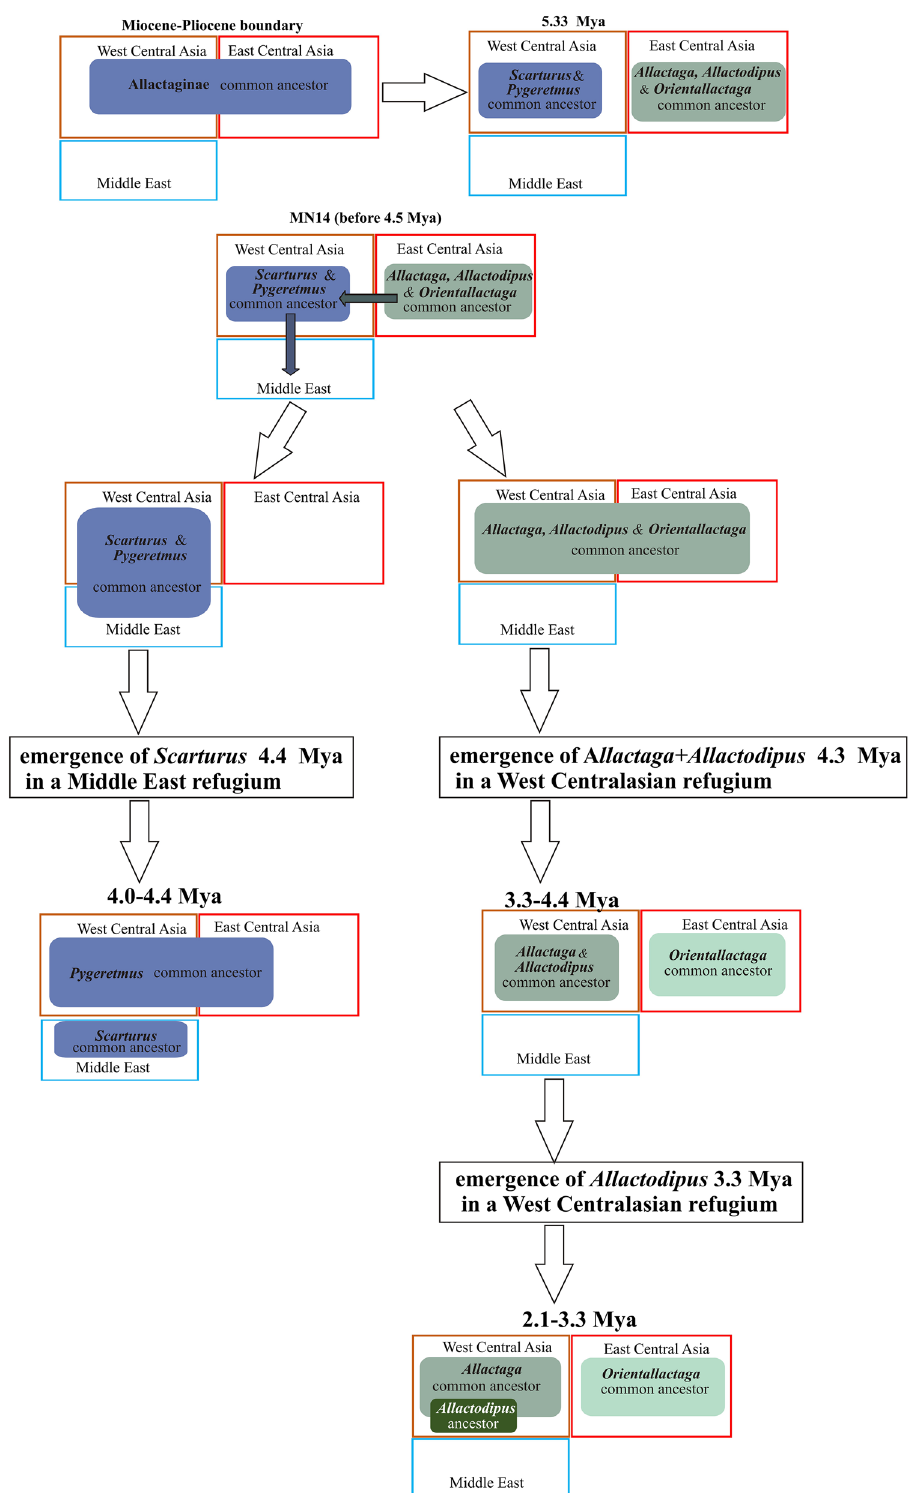
Figure 6. Hypothetical scenario of range evolution and geography of speciation during the early stages in phylogenetic history of Allactaginae. See text for